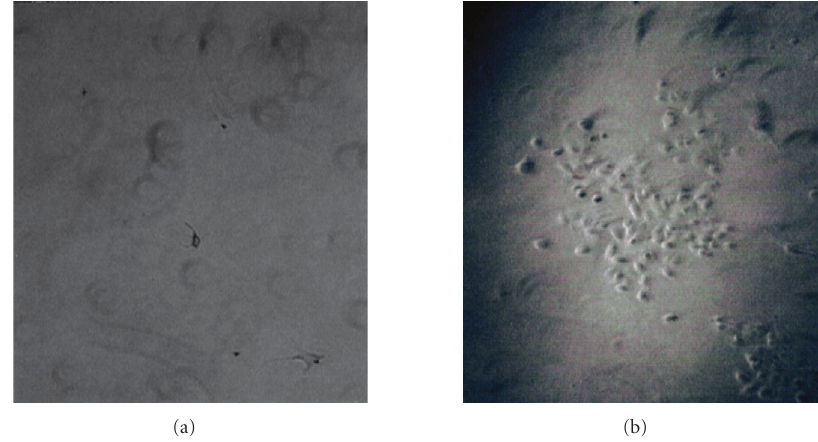
Figure 3: Long-term e ff ect of combined ionizing radiation (IR) and parvovirus H-1 (H-1PV) infection on human high-grade glioma cells. Short- term cultures of human glioblastoma NCH-89 were irradiated with 20Gy, and infected with H-1PV at an MOI of 5 PFU/cell 24 hours post-IR. 3-week postseeding photographs of culture dishes were taken at a magnification of 400 × and no surviving cells could be found (a). In comparison, after mono treatment with H-1PV at an MOI of 5 PFU/cell or after mono treatment with IR (data not shown), proliferating cell clones could be observed (b).